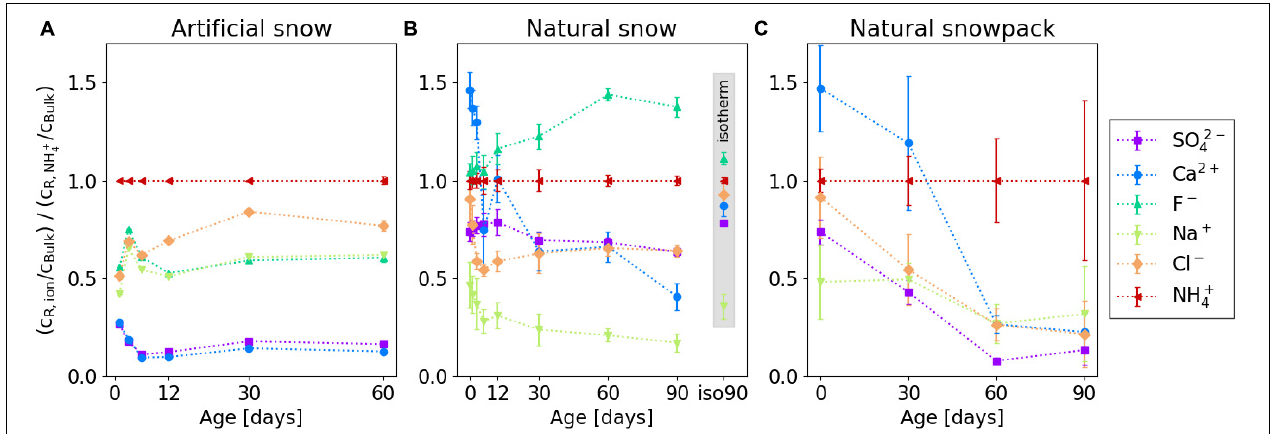
FIGURE 7 | Concentration ratios of the individual ions in relation to NH 4 + in the residual samples. Shown are results for (A) controlled metamorphism, artificial snow; (B) controlled metamorphism, natural snow; and (C) natural metamorphism, natural snowpack. Data points within the gray inset (panel B ) represent a sample isothermally stored for 90 days at –20 ◦ C. Error bars represent 1 σ uncertainties from analyzing three different samples.